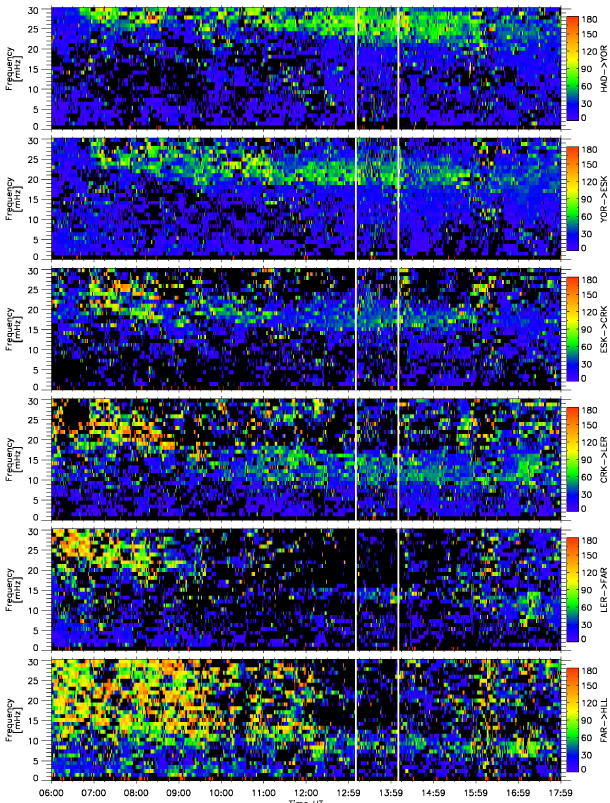
Fig. 9. Cross-phase spectra of stations belonging to the SAMNET array.